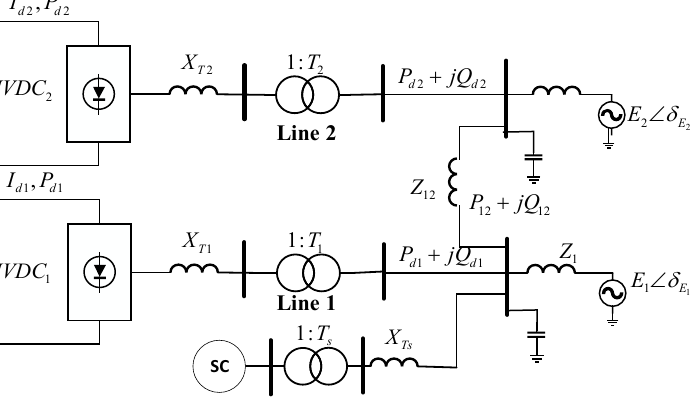
Figure 1. Model of double-infeed LCC-HVDCs with SCs. The control modes of the first HVDC subsystem (HVDC 1 ) and the second HVDC subsystem (HVDC 2 ) are constant current control and minimum trigger angle control at the rectifier side and constant extinction angle control and constant current control at the inverter side.